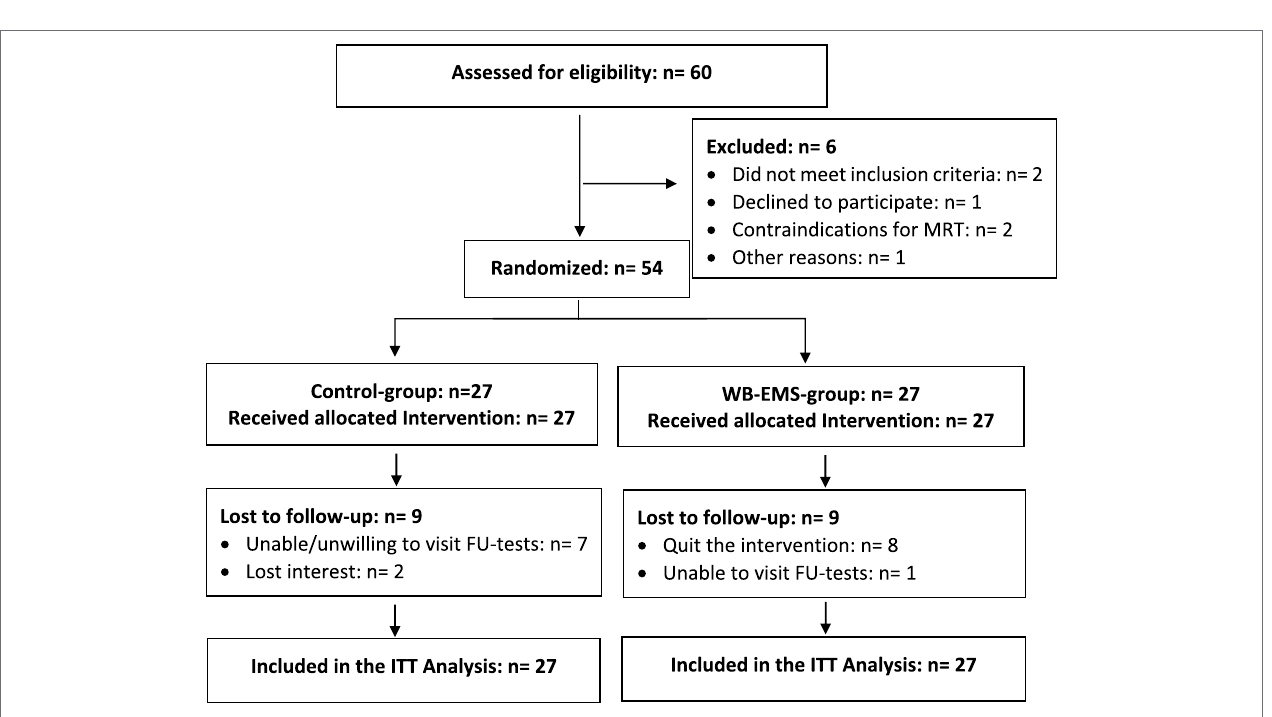
FIGURE 1 | Segmentation and analysis of the magnetic resonance images. Left: T 1 -weighted image used for segmentation of the fascia (magenta), outline (blue), and femur (green). Center: Dixon image after registration of the analysis volumes. Right: Dixon image – separation into IMAT (yellow) and MT (light red) volumes.